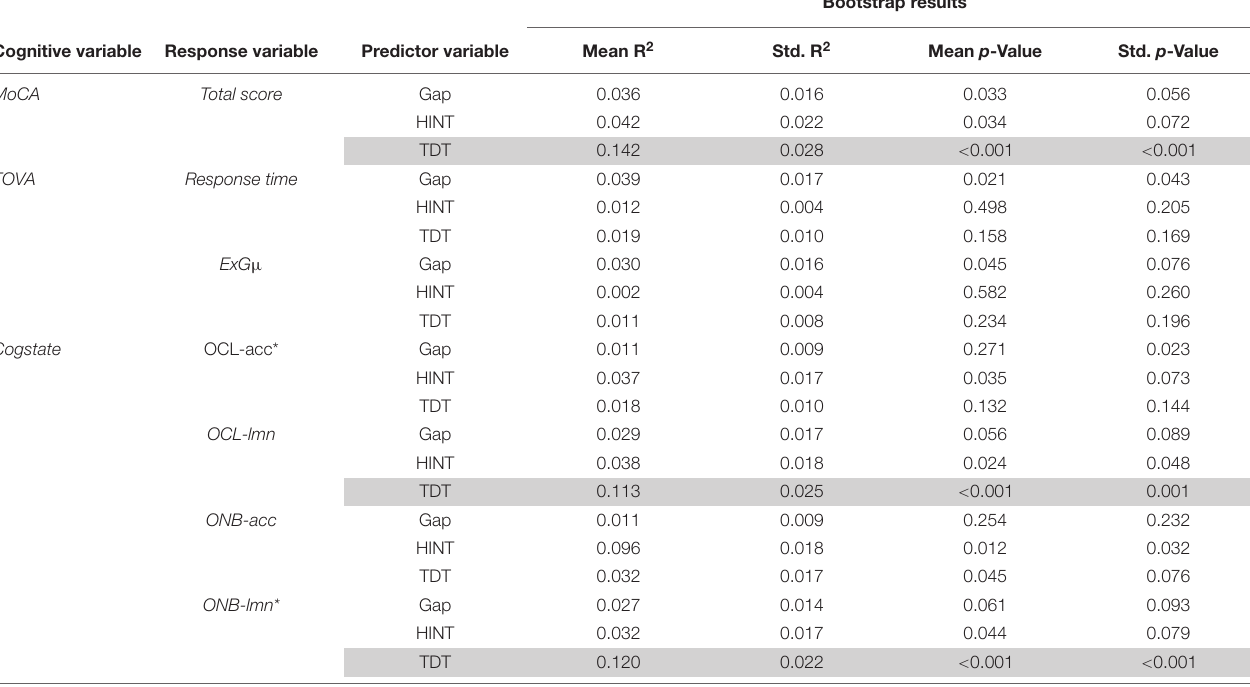
TABLE 4 | Bootstrap